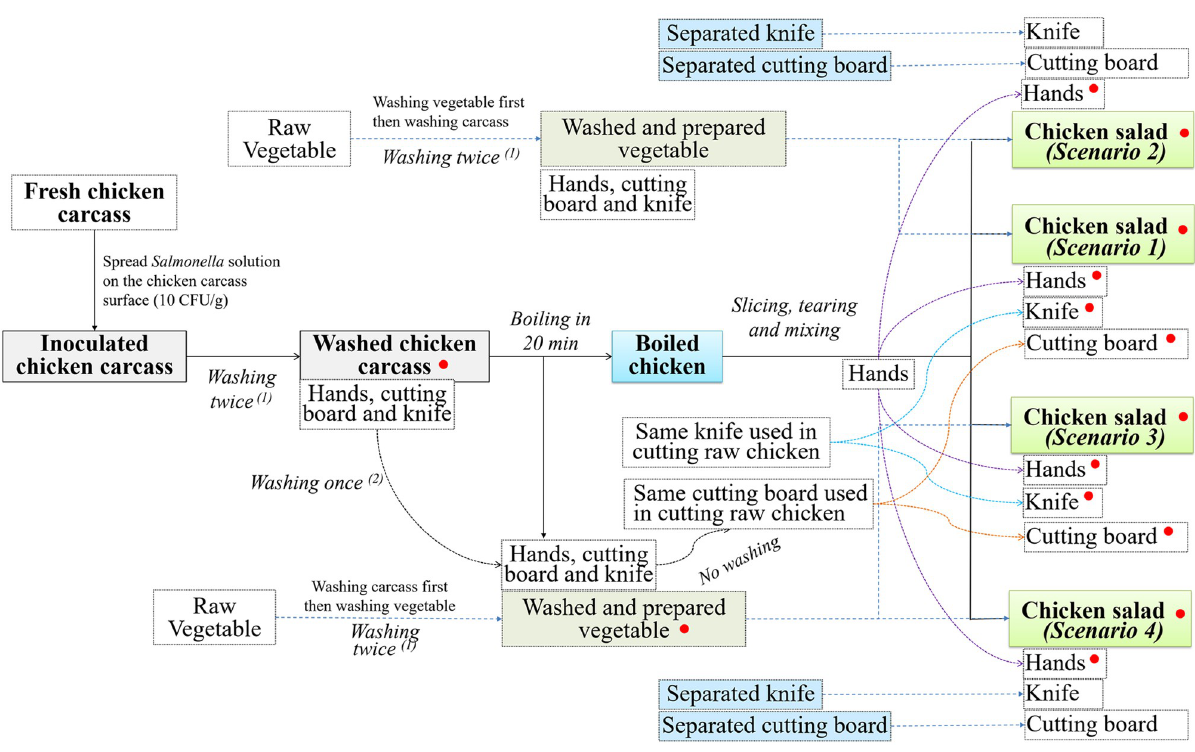
Fig 1. The scenario diagram of the preparation and practice steps of cooking chicken salad, including the sampling points. Red dots indicate the sampling types and stages collected during the experiment of each scenario: 1 washing with clean, Salmonella -free water; 2 washing with clean, Salmonella -free water, dishwashing detergent and clean